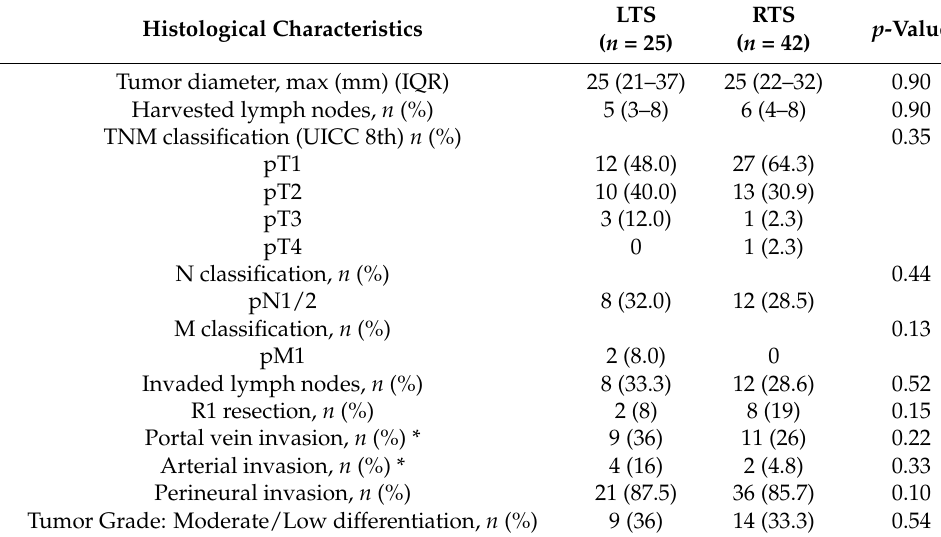
Table 3. Histological characteristics of the